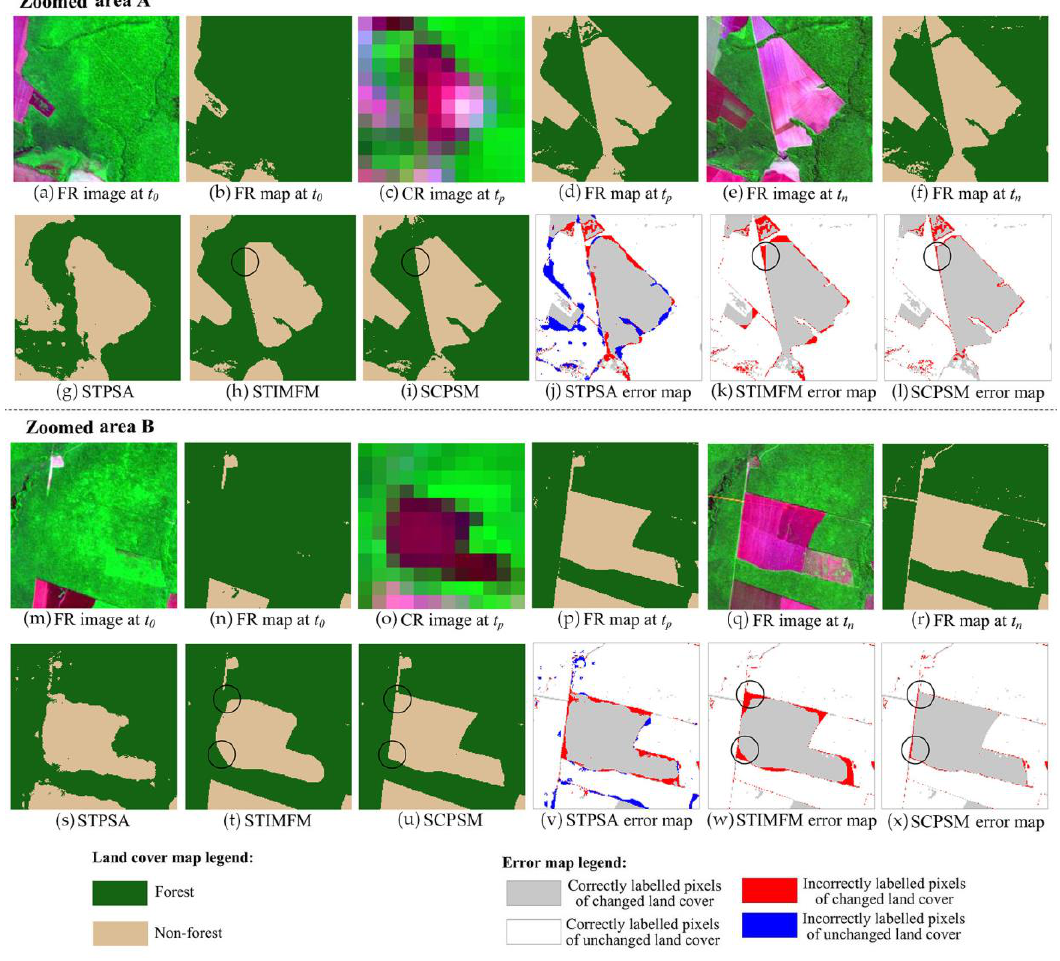
Figure 11. Input, reference, resulting land cover maps and error maps for the zoomed areas in Figure 10 in the forest clearance experiment. Each zoomed area contains 192 × 192 FR pixels. ( a )–( l ) are the input, reference, resulting maps and error maps for zoomed area A: ( a ) FR image at t 0 ; ( b ) FR map at t 0 ; ( c ) CR image at t p ; ( d ) FR map at t p ; ( e ) FR image at t n ; ( f ) FR map at t n ; ( g ) STPSA; ( h ) STIMFM; ( i ) SCPSM; ( j ) STPSA error map; ( k ) STIMFM error map; ( l ) SCPSM error map. ( m )–( x ) are the input, reference, resulting maps and error maps for zoomed area B: ( m ) FR image at t 0 ; ( n ) FR map at t 0 ; ( o ) CR image at t p ; ( p ) FR map at t p ; ( q ) FR image at t n ; ( r ) FR map at t n ; ( s ) STPSA; ( t ) STIMFM; ( u ) SCPSM; ( v ) STPSA error map; ( w ) STIMFM error map; ( x ) SCPSM error